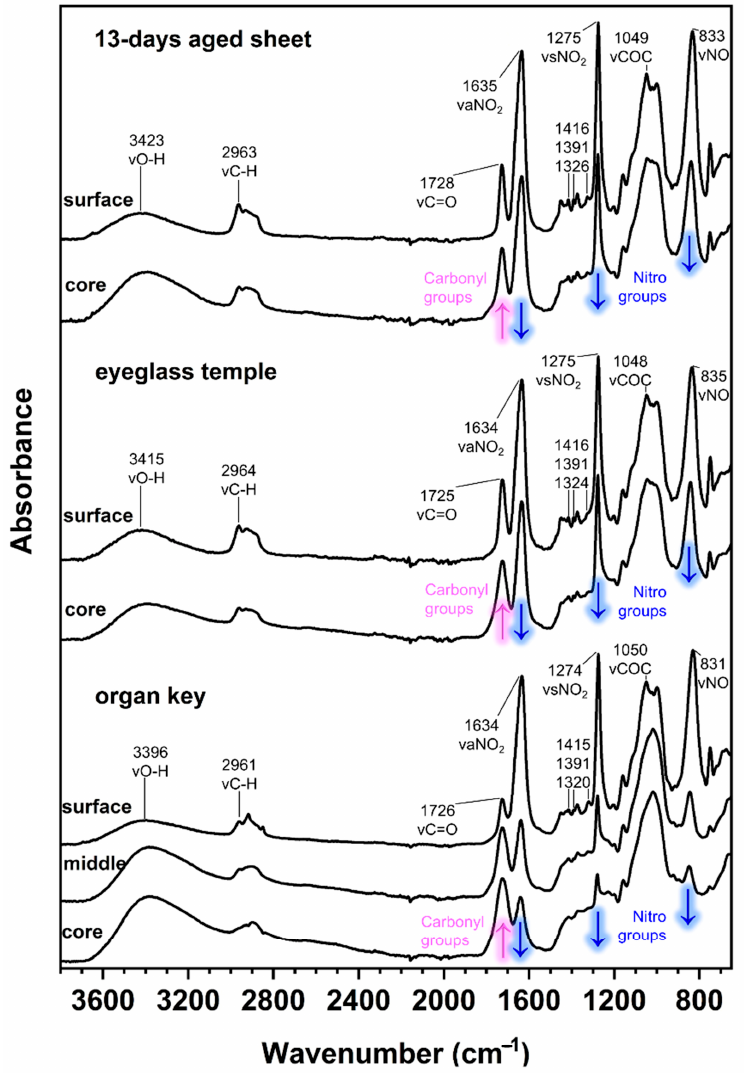
Figure 11. Normalized ATR-FTIR spectra of the 13-day artificially aged sheets collected in position A (up), eyeglasses temple (middle) and organ key (bottom) at different depths. The magenta and blue arrows show the changes in absorption along increasing depth.